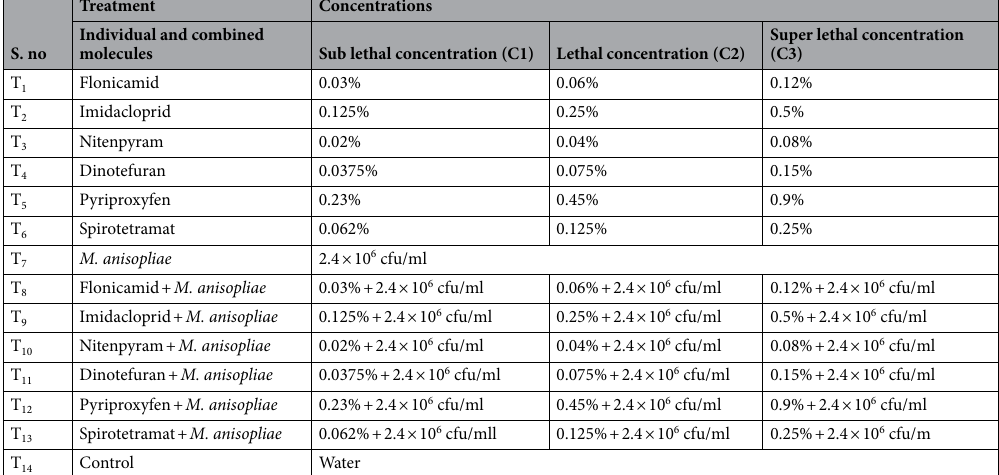
Table 1. Insecticides and entomopathogenic fungi individual and combined application with different doses used for laboratory